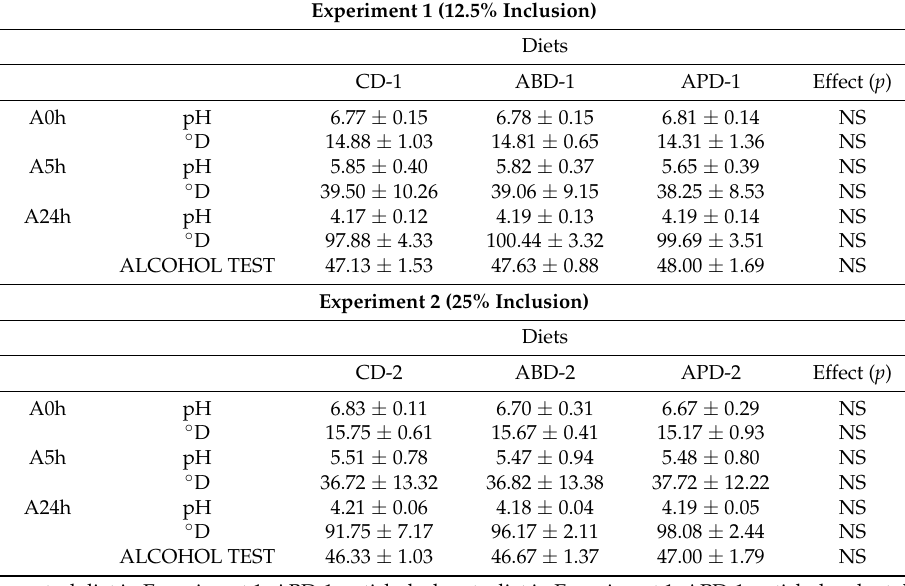
Table 4. pH and Dornic acidity ( ◦ D) at 0, 5 and 24 h of incubation (acidification capacity test) and alcohol test of the milk from Murciano-Granadina goats fed on diets containing or not containing artichoke by-products (plant and outer bracts) in the Experiment 1 (12.5% inclusion) and Experiment 2 (25%